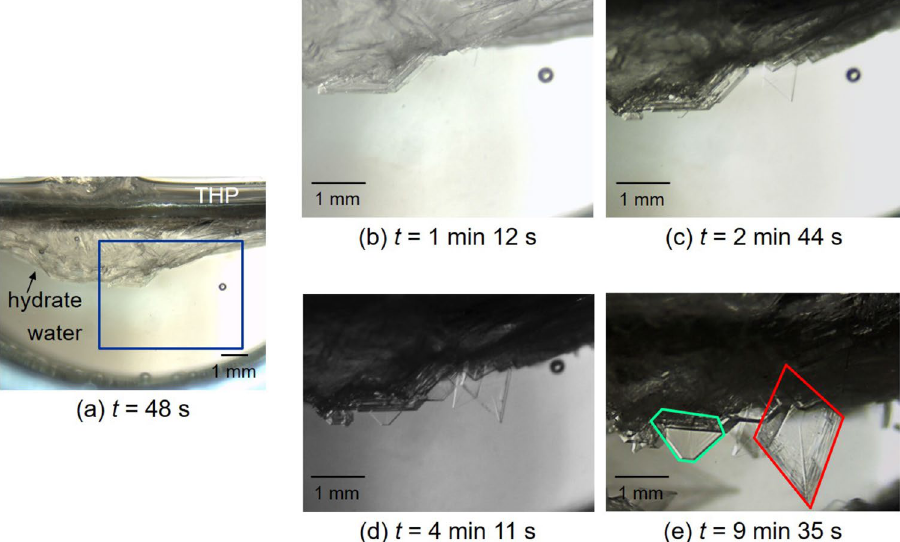
Figure 5. Sequential close-up images of H 2 + CO 2 + THP hydrate crystal plates growing in the bulk of liquid water at Δ T sub = 4.8 K under P = 5.08 MPa. The gas composition was H 2 :CO 2 = 0.65:0.35 in mole fraction. The elapsed time after the hydrate nucleation is indicated below each